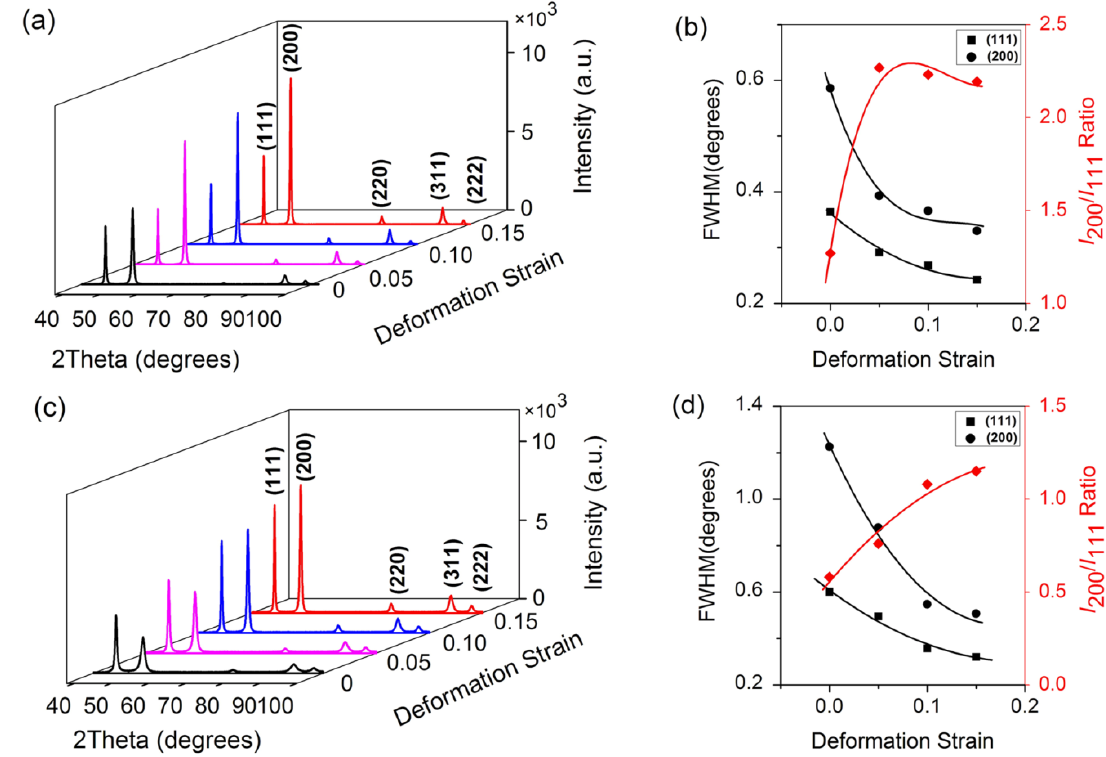
Figure 4: XRD patterns of (a) NC Ni and (c) NC Ni-Fe samples at various deformation stains. The corresponding (200)/(111) diffraction in- tensity ratio (I200 / I111) and FWHMs of (111) and (200) diffraction planes with increasing strain are shown in (b) NC Ni and (d) NC Ni-Fe, respectively.